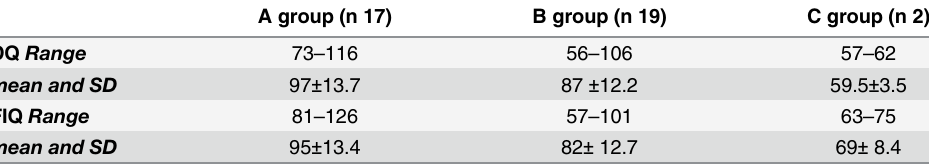
Table 2. Correlation between specific Neurodevelopmental and Wechsler